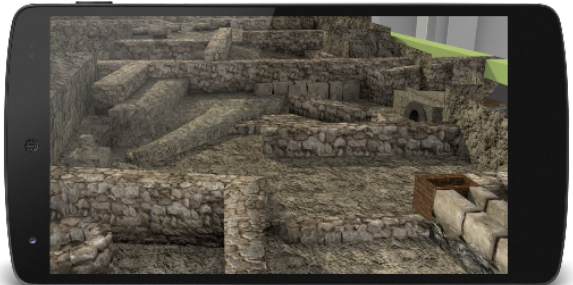
Figure 9: A Nexus 5 viewing the vestiges from different periods discovered in the same area in the three archaeological excava-